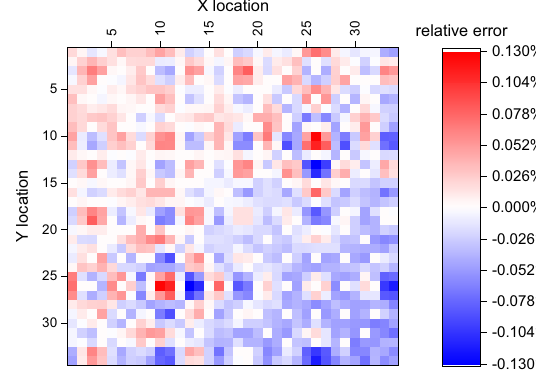
Figure 2: Relative Error of Predicated Power in C5G7 Core Using SP3